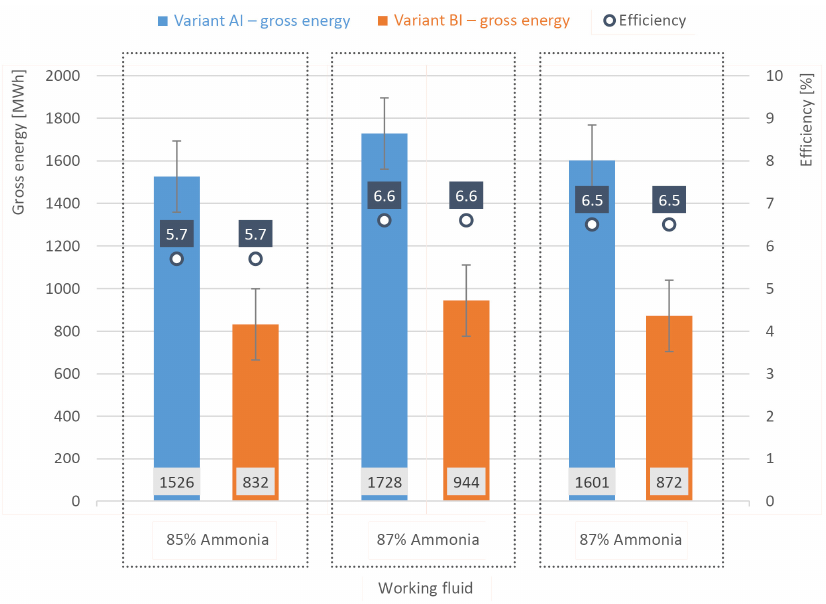
Figure 7. Comparison of results for gross power and efficiency obtained in variants AI and BI using the Kalina Cycle.